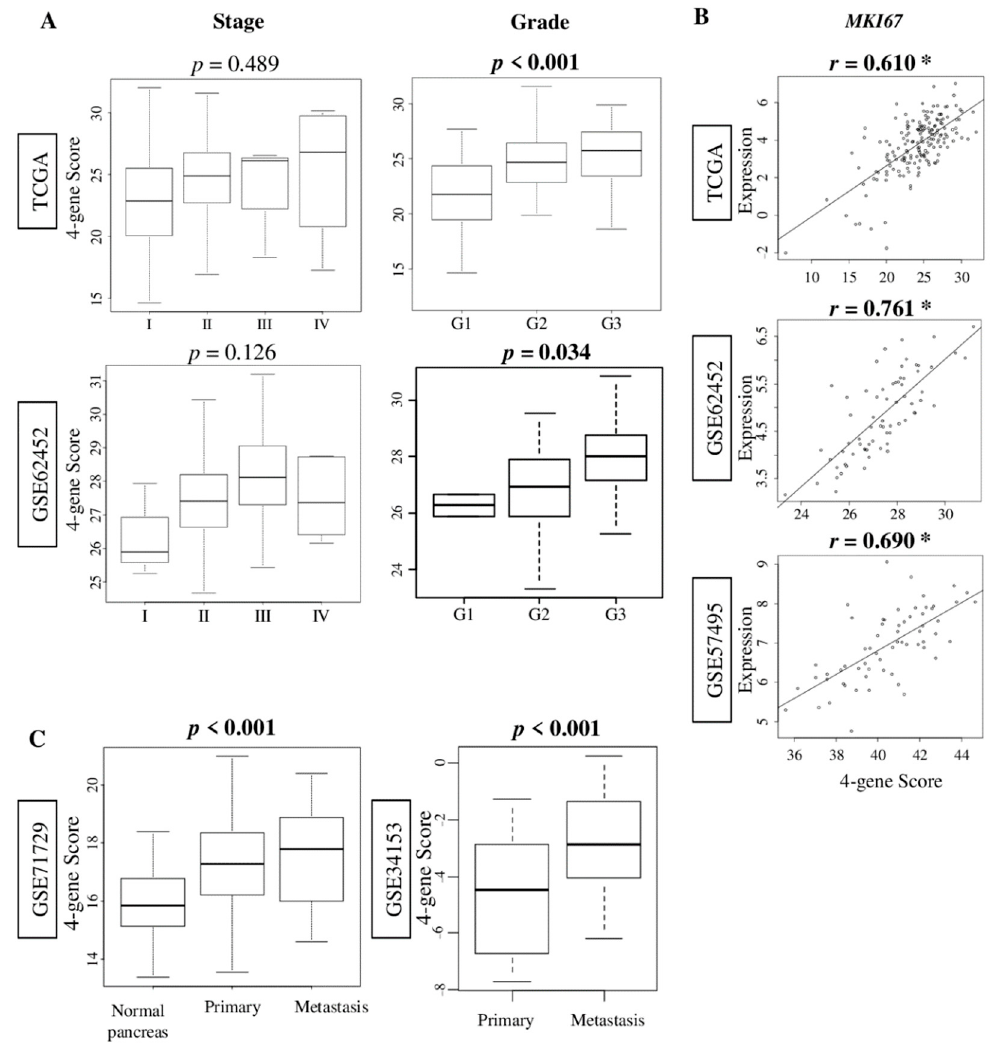
Figure 2. Association of the four-gene score with cell proliferation and metastatic pancreatic cancer. ( A ) Boxplots of the four-gene score by the American Joint Committee on Cancer stage, and Nottingham pathological grade in the TCGA, GSE62452, and GSE57495 cohorts. One-way ANOVA was used for the calculation. ( B ) Correlation plots of the four-gene score with expression of the MKI67 gene in the TCGA, GSE62452, and GSE57495 cohorts. Spearman correlation statistics were used in the analysis. * p -value < 0.01. ( C ) Boxplot of the four-gene score between a normal pancreas, as well as primary and metastatic pancreatic cancer in GSE71729 and GSE34153 cohorts. One-way ANOVA was used to the calculation. Tukey-type boxplots showed median and interquartile level values.